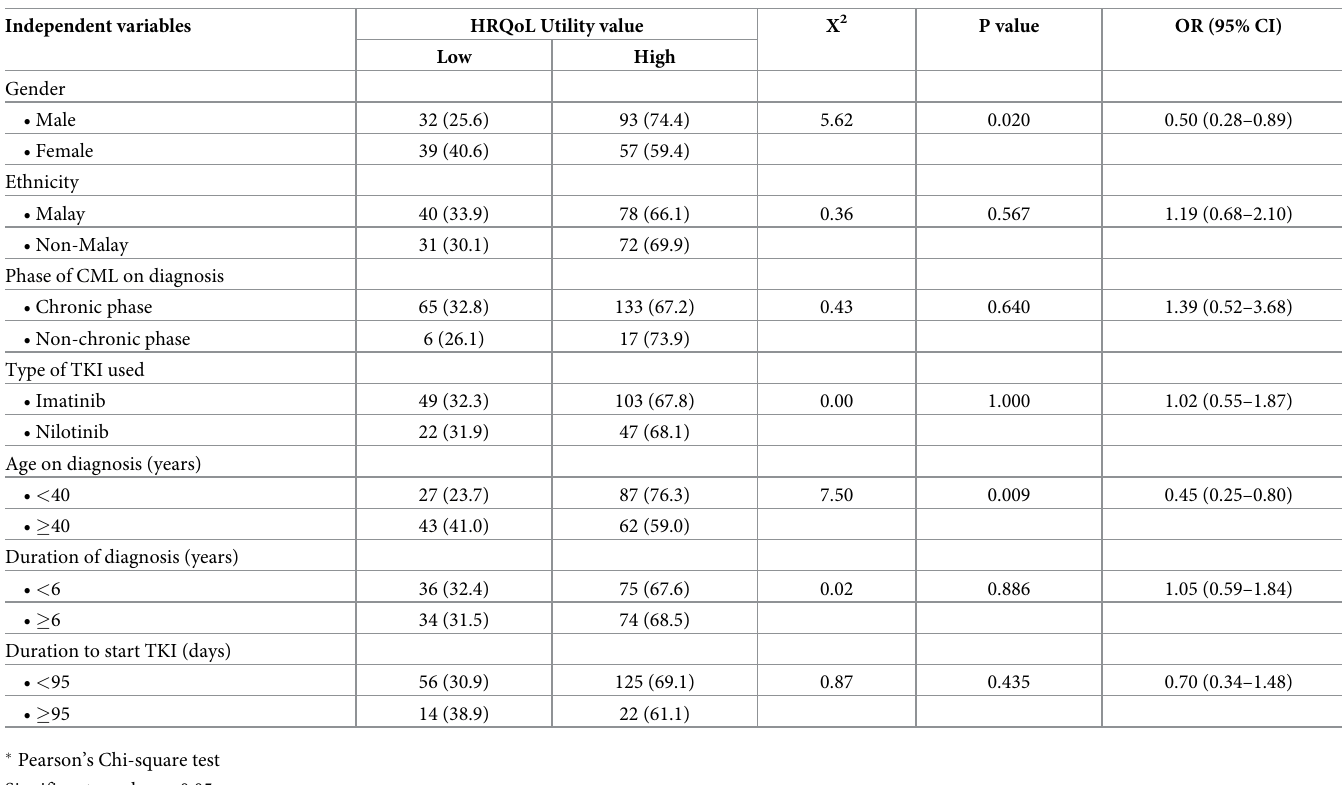
Table 2. Bivariate analysis of CML risk factors towards HRQoL utility